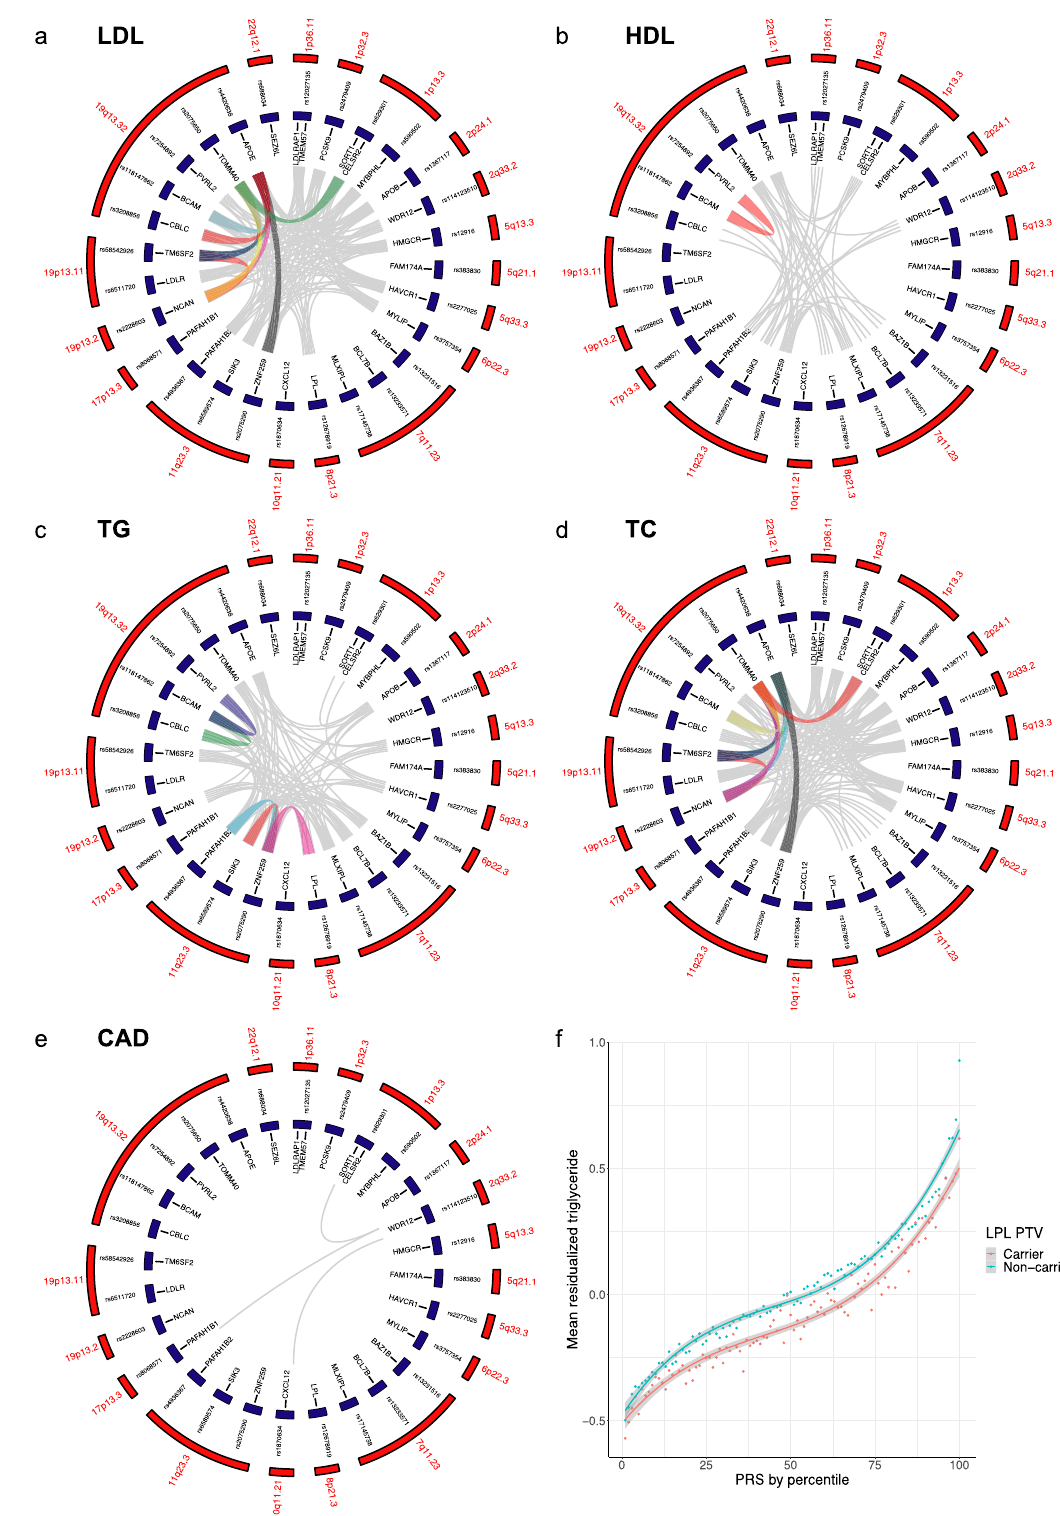
Fig. 2 Pairwise genetic effects between lipid and CAD GWAS lead SNPs in 387,033 UK Biobank participants. a – e Circos plots showing AEs (grey) and GIs (coloured) between GWAS lead SNPs (blue) at the 28 selected lipid/CAD loci (red) for the four tested lipid species and CAD. f Tests for GIs between polygenic risk scores (PRS) for the four lipid species and PTV burden for each of the 30 lipid genes identi fi ed a GI between PTV burden in LPL and the PRS for TG. PRS distribution (mean ± SD) for LPL -PTV carriers (pink) and non-carriers (blue) are plotted against mean normalized residual TG levels. Each dot re fl ects mean TG levels at a respective